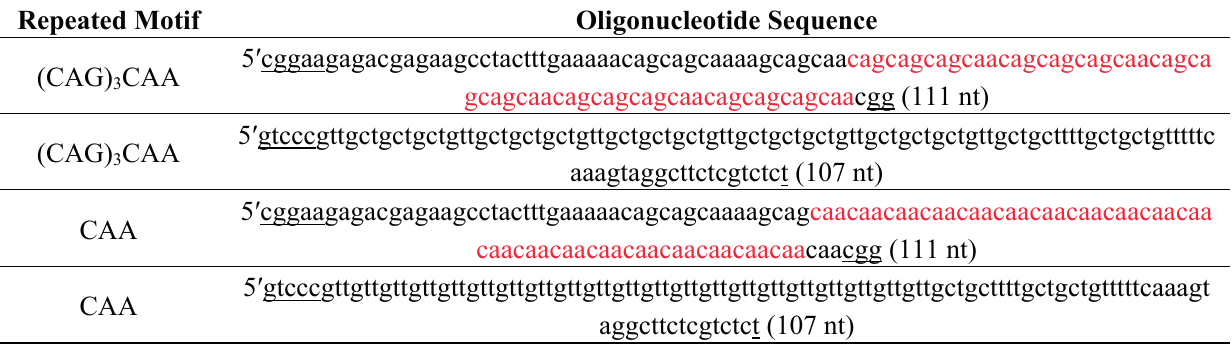
Table 2. Sequences of synthetic oligonucleotides. Repeat tracts are shown in red and restriction sites are